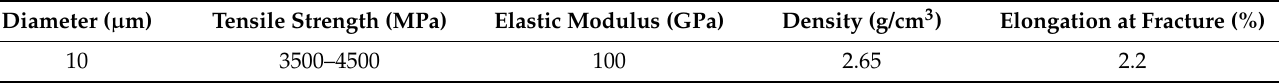
Table 2. Physical and mechanical properties of basalt